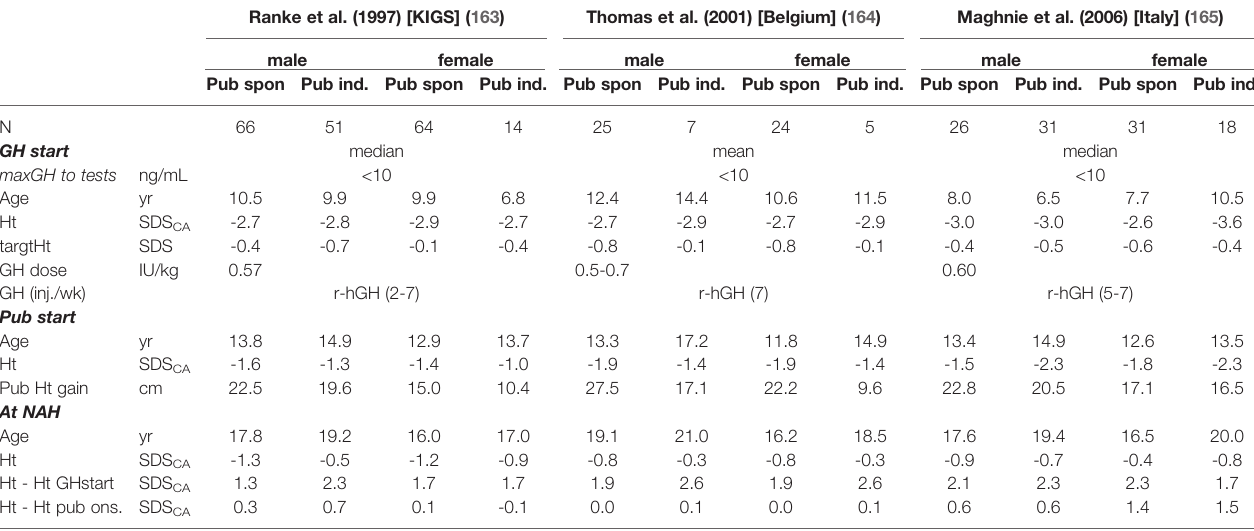
TABLE 3 | Examples of height in children with non-acquired GHD: start GH, puberty onset (spontaneous vs . induced), near adult height (NAH). Ranke et al. (1997) [KIGS] (163)